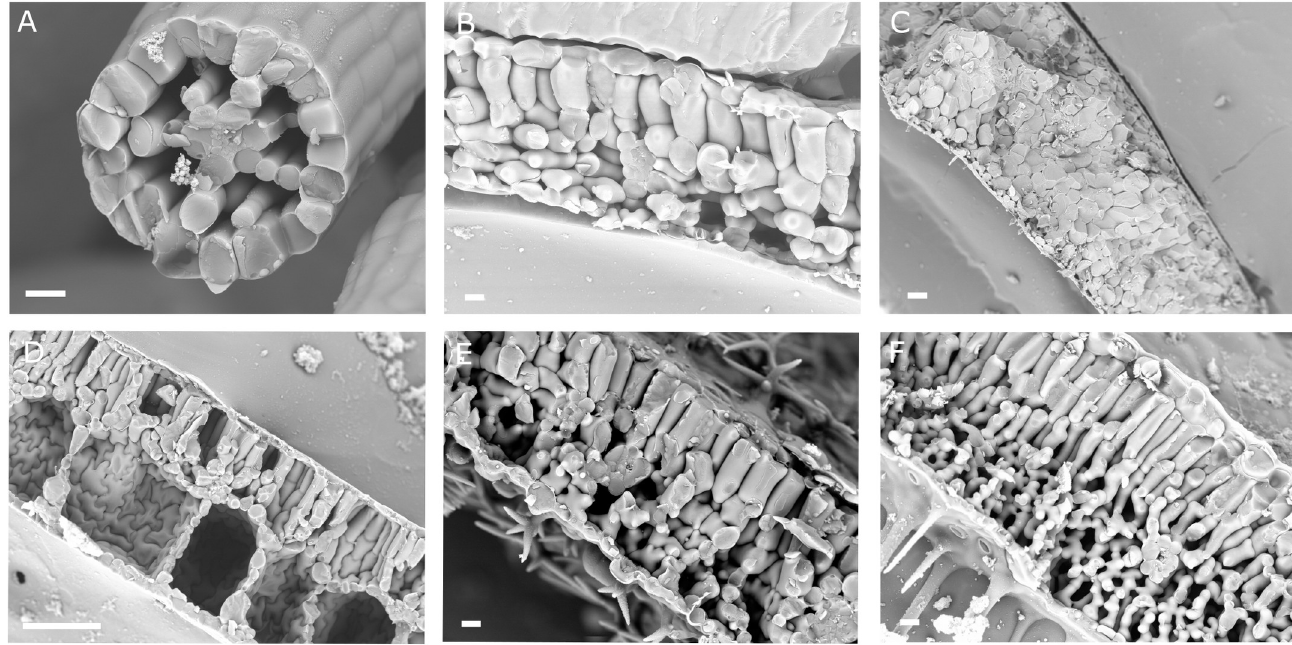
Fig 1. Leaf air space patterns vary between species. Freeze fracture scanning electron micrographs of leaf air spaces in the aquatic Utricularia gibba (A) , the mesophyte Arabidopsis thaliana (B) , the succulent xerophyte Aeonium arboreum (C) , the aquatic Hydrocharis morsus-ranae (D) , and the mesophytes Lavandula angustifolia (E) and Verbena bonariensis (F) . All leaves are arranged with the adaxial (upper) surface upmost, apart from U . gibba (A), which is radial. Scale bars are 20 μ m in A, B, E, and F and 200 μ m in C and D.